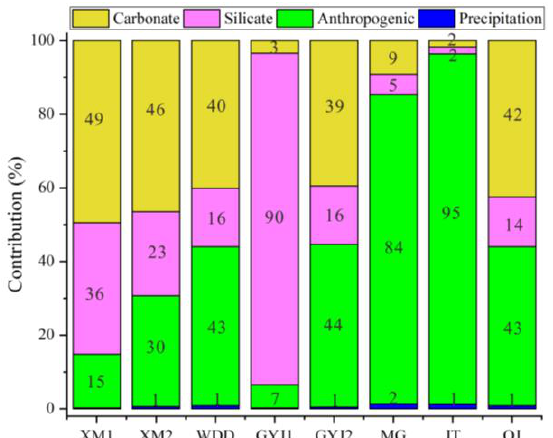
Figure 8. The percentage contribution of various ions sources for soil − soluble salt in the soil pro-